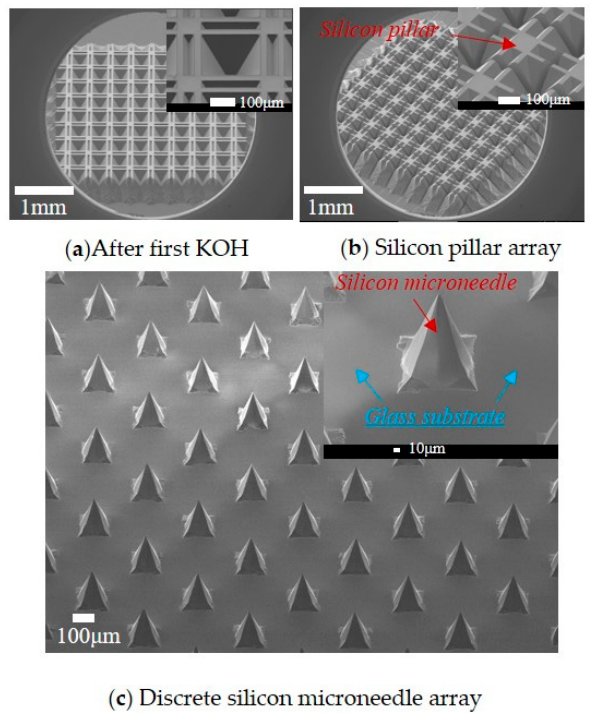
Figure 4. Fabrication process of microneedle array.